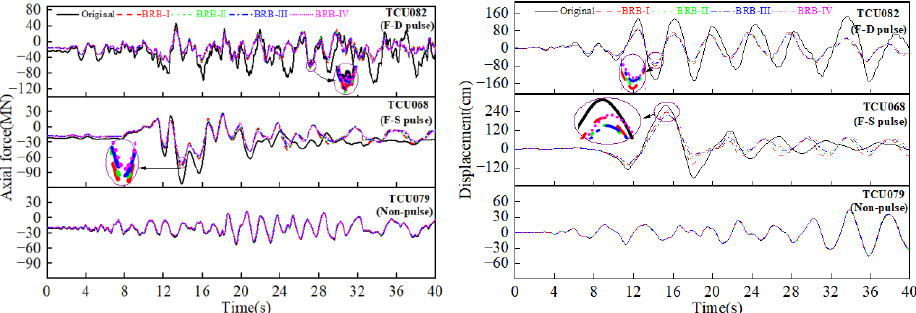
Figure 15. Time history curve of transverse deformation of vault section under the action of TCU082.